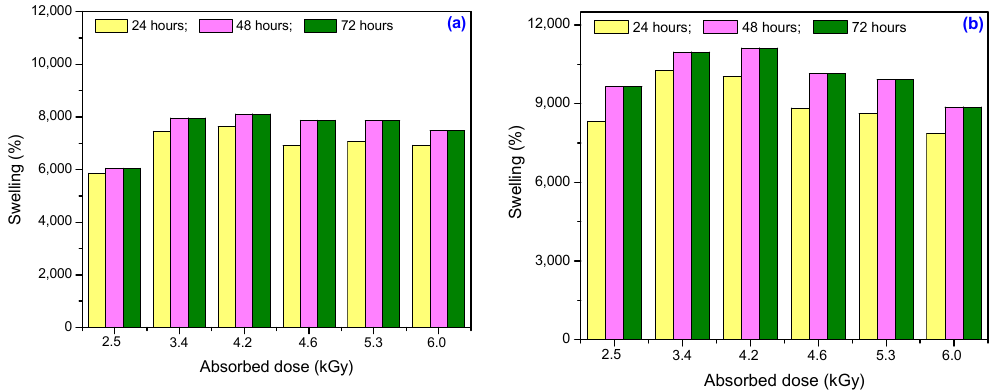
Figure 2. The effect of the absorbed dose on the hydrogels’ water uptake at 24, 48 and 72 h: ( a ) 3.70 × 10 − 3 mol/L PP and 2.95 × 10 − 3 mol/L TMPT; ( b ) 7.40 × 10 − 3 mol/L PP and 5.90 × 10 − 3 mol/L TMPT.